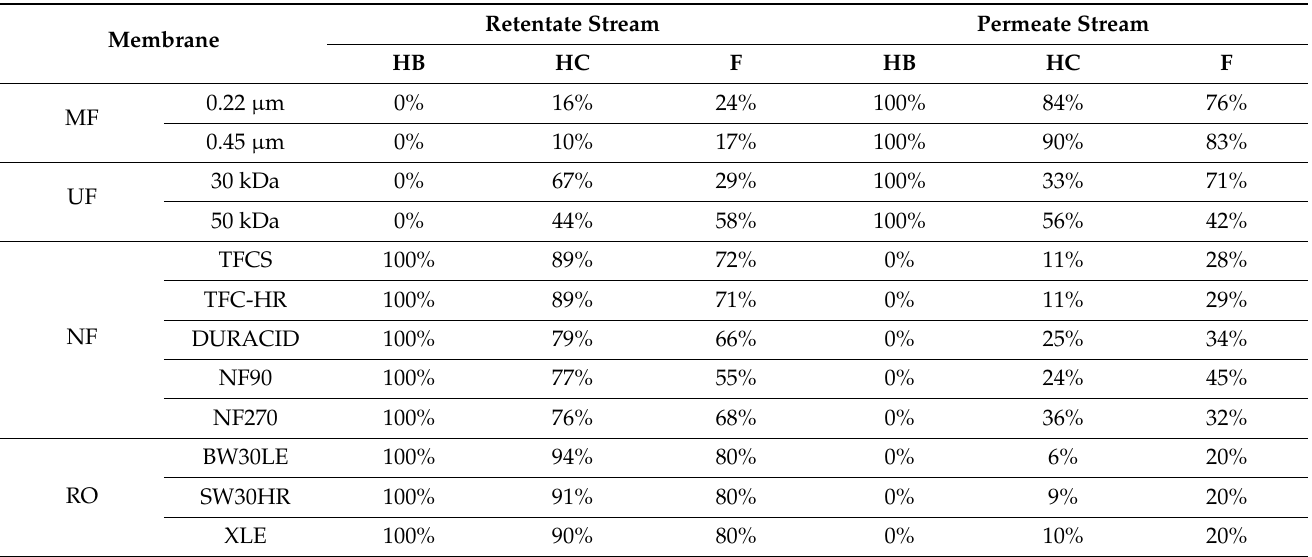
Table 3. Results of the rejection of each polyphenol family obtained with orange extracts for the MF, UF, NF, and RO membranes (means of the two